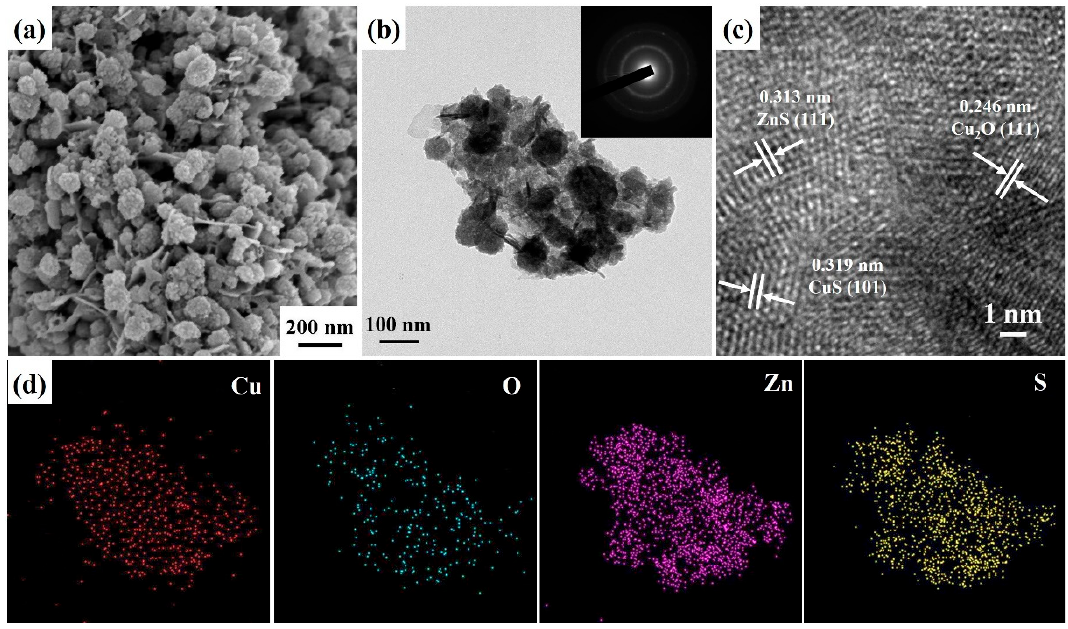
Figure 2. ( a ) FE-SEM, ( b ) FE-TEM, ( c ) SAED pattern, and ( d ) HRTEM images of Cu 2 O nanostructures.